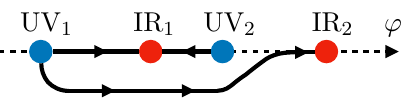
Figure 5. Schematic structure of a (cid:12)eld theory which presents multiple RG-(cid:13)ows: in particular, there are two (cid:13)ows starting at the (cid:12)xed point UV 1 , one going to the closer IR (cid:12)xed point IR 1 , the second skipping IR 1 and ending at IR 2